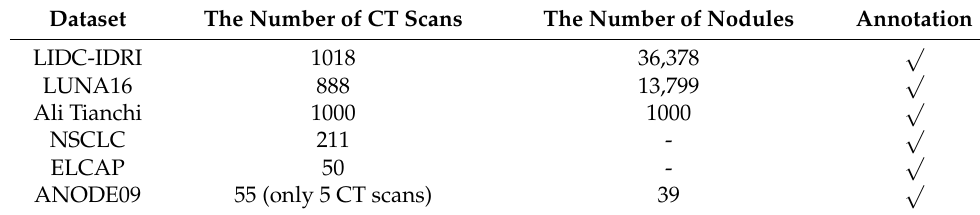
Table 1. Cited datasets and their composition.